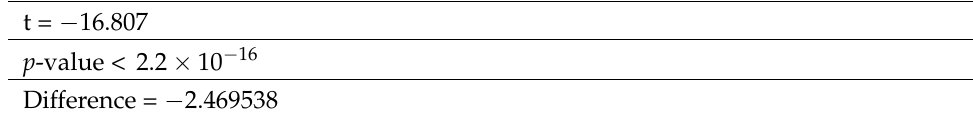
Table 4. Results of paired t -test applied to the data of Experiment 2.